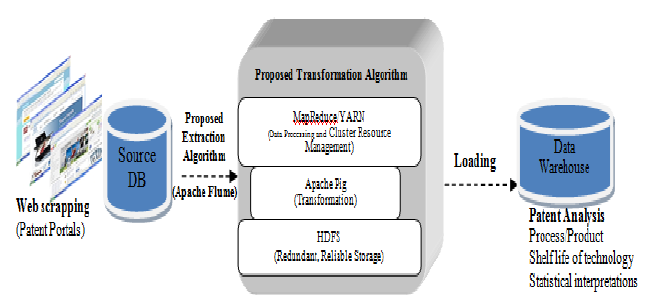
Figure 2 . Web ETL Framework